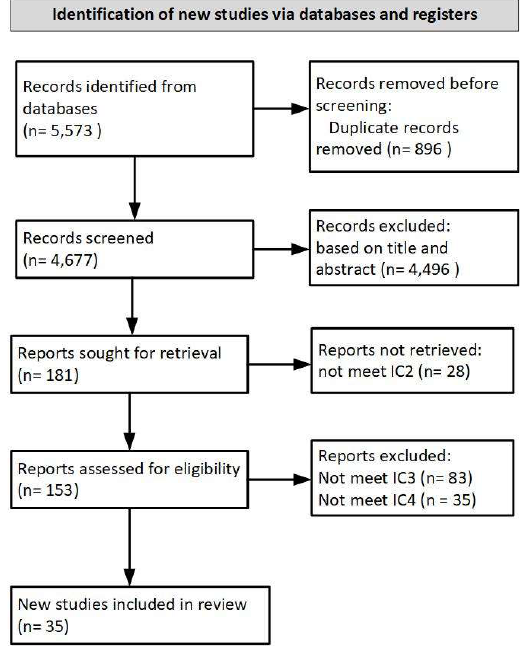
Figure 1. PRISMA workflow diagram (IC = Inclusion Criteria).